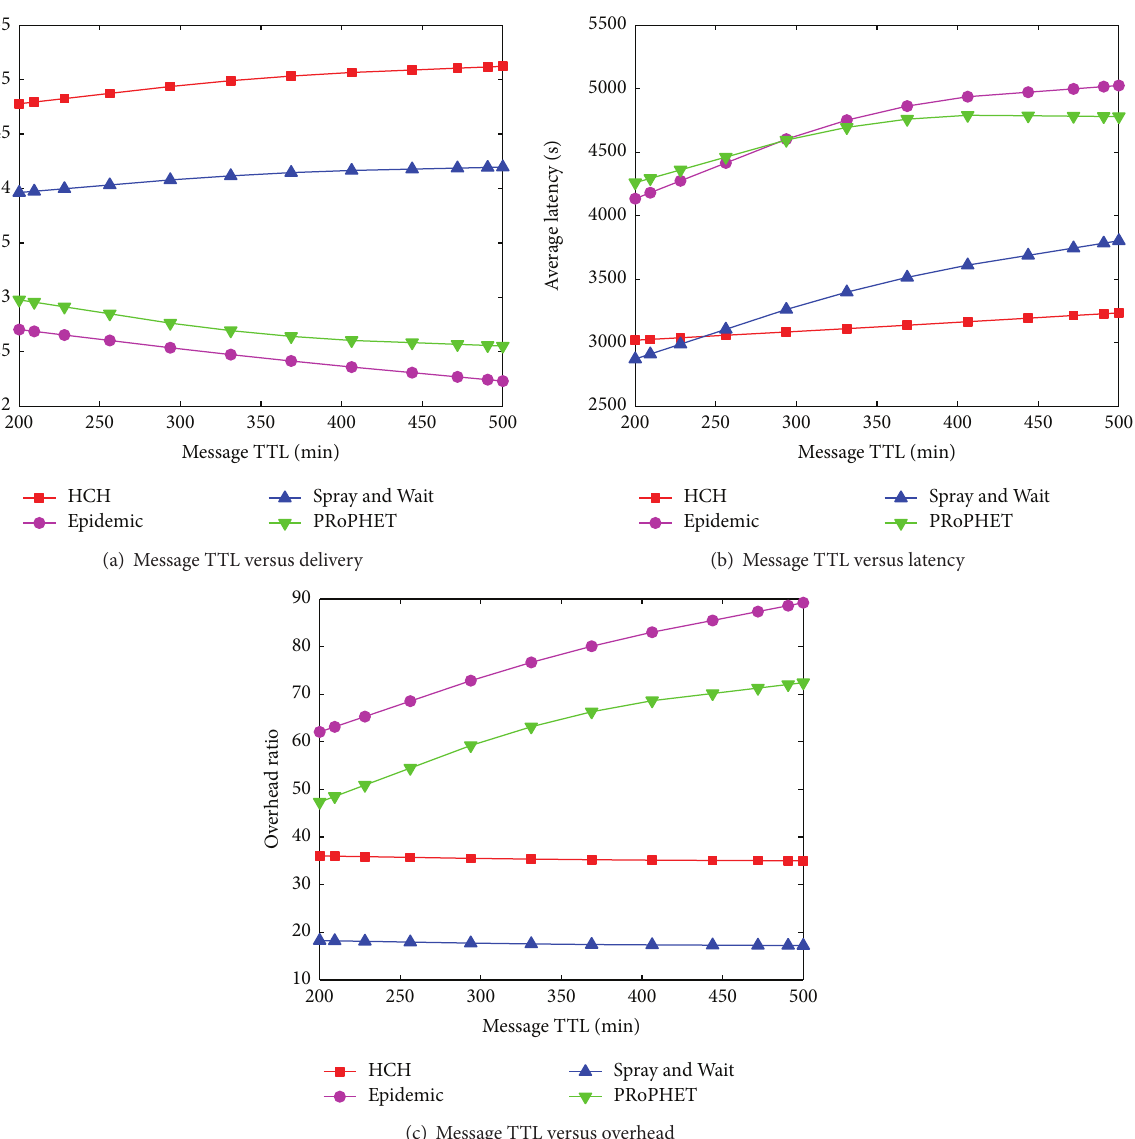
Figure 6: [Helsinki City Scenario] Message TTL versus delivery ratio, average latency, and overhead ratio.